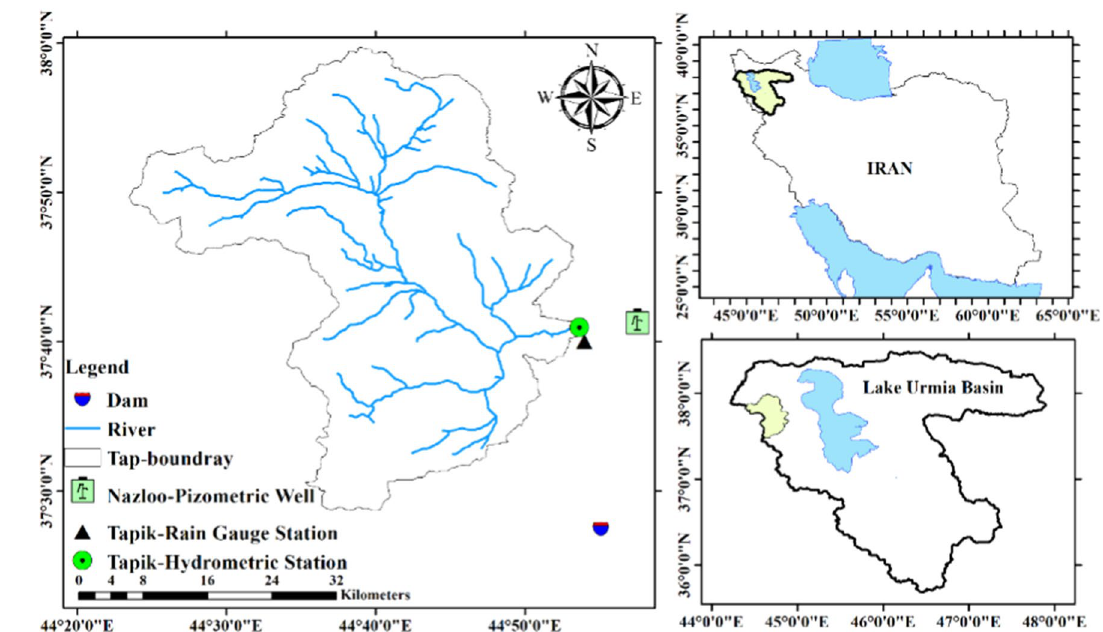
Fig. 1 Geographical location of Tapik basin in Iran and Lake Urmia